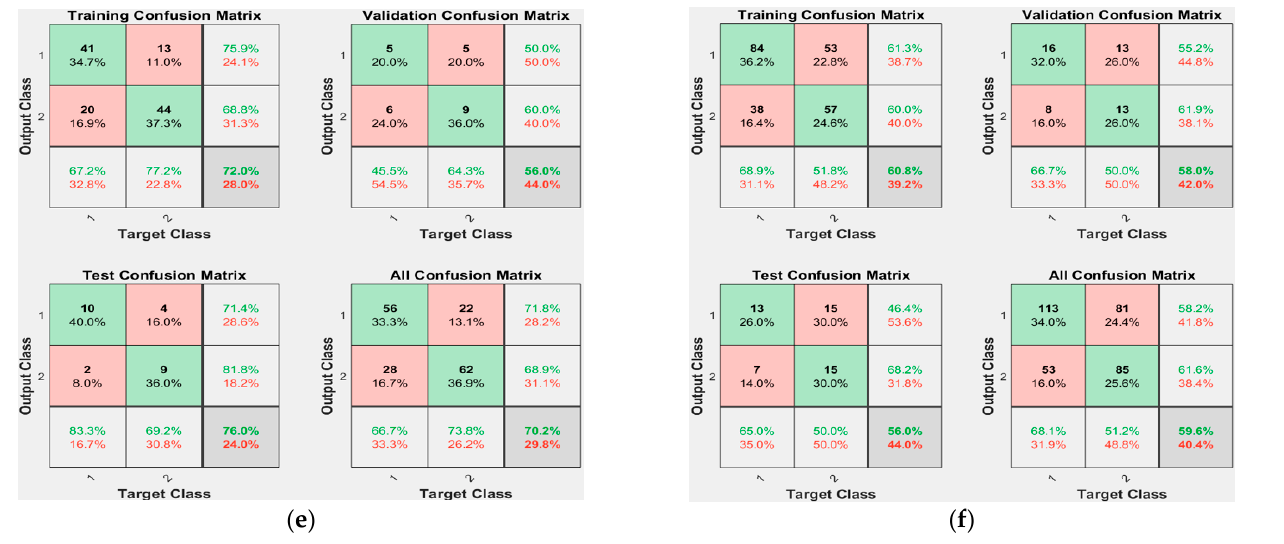
Figure 9. Confusion matrices of Deep-IDH models using different hidden layers and data lengths: ( a ) 1-layer and 60-min data before IDH occurrence (69.2%, 30.8%); ( b ) 1-layer and 45-min data before IDH onset (73.2%, 26.8%); ( c ) 1-layer and 30-min data before IDH onset (64.5%, 35.5%); ( d ) 2-layer and 60-min data before IDH onset (81.5%, 18.5%); ( e ) 2-layer and 45-min data before IDH onset (70.2%, 29.8%); and ( f ) 2-layer and 30-min data before IDH onset (59.6%, 40.4%). Table 5. Performance of Deep-IDH models using different hidden layers and data